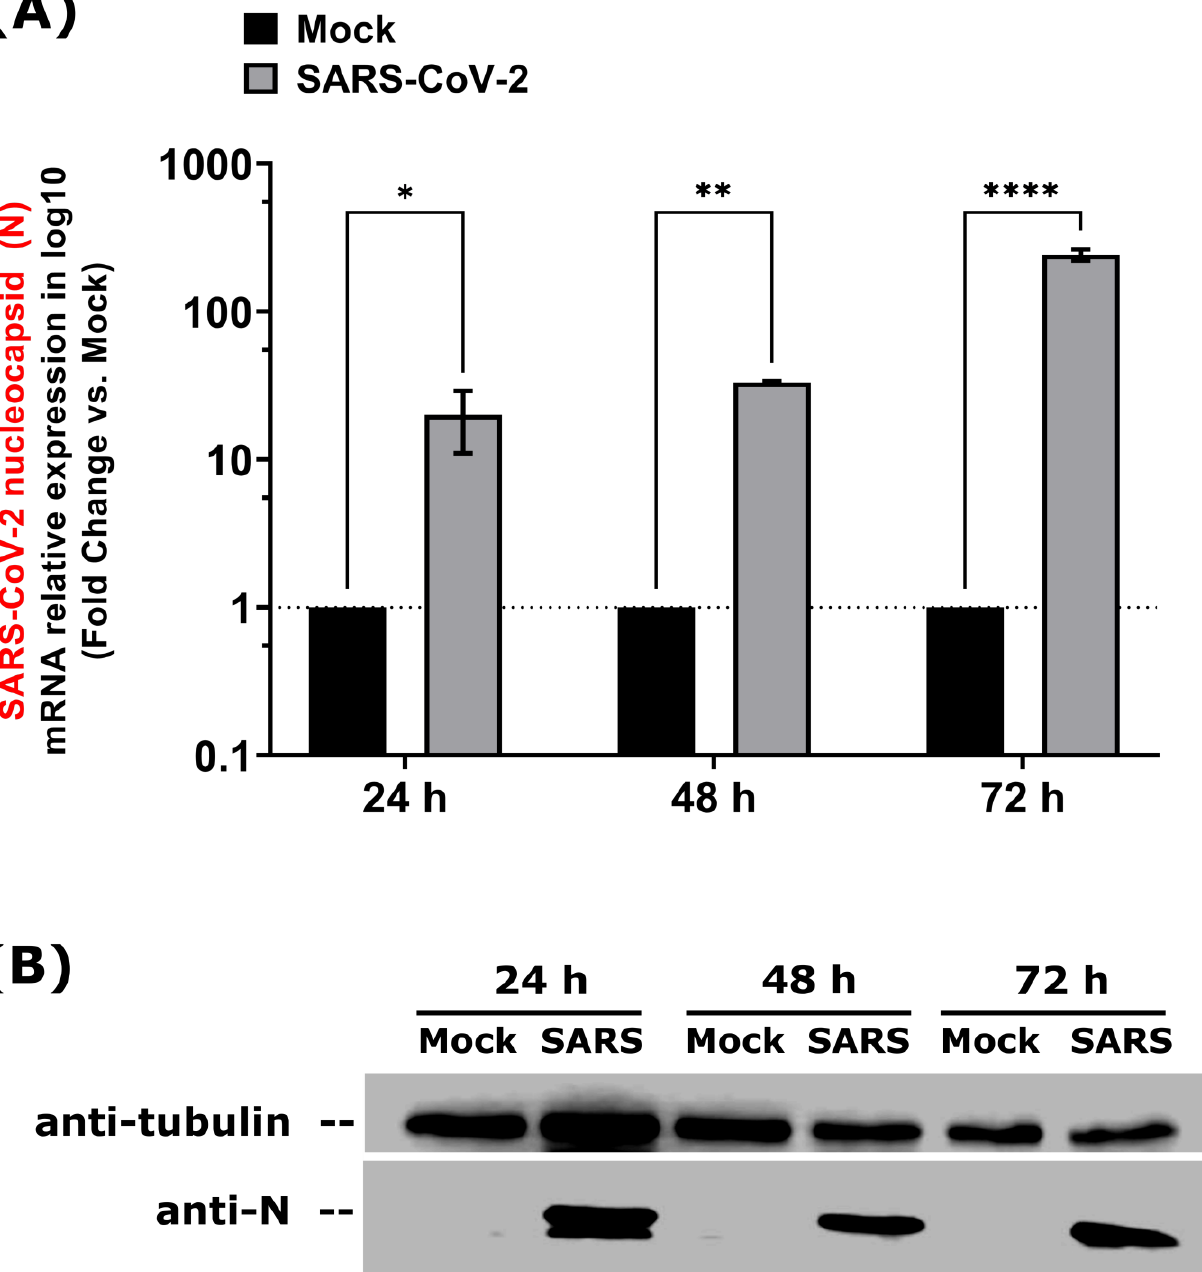
Figure 1. SARS-CoV-2 replication in Calu-3 cells. SARS-CoV-2 nucleocapsid gene (N) expression was monitored upon SARS-CoV-2 infection in Calu-3 cells by RT-qPCR ( A ) using specific primers and Western blot ( B ) using anti-N (42kDa) and anti-Tubulin (55 kDa, control) antibodies. qPCR data were normalized to a reference gene (Actin beta, ACTB ), reported to mock (unrelated negative control) and expressed using a relative quantitation method (ddCT). Statistical analysis. All data ( A ) presented were calculated from three biological replicate ( n = 3) measurements ± SD. The ordinary two-way analysis of variance (ANOVA) and Šídák’s multiple comparisons test were used for statis- tical analysis. Statistically significant differences (fold change vs. mock) are indicated by stars (*): * p < 0.05; ** p < 0.01; **** p < 0.0001.